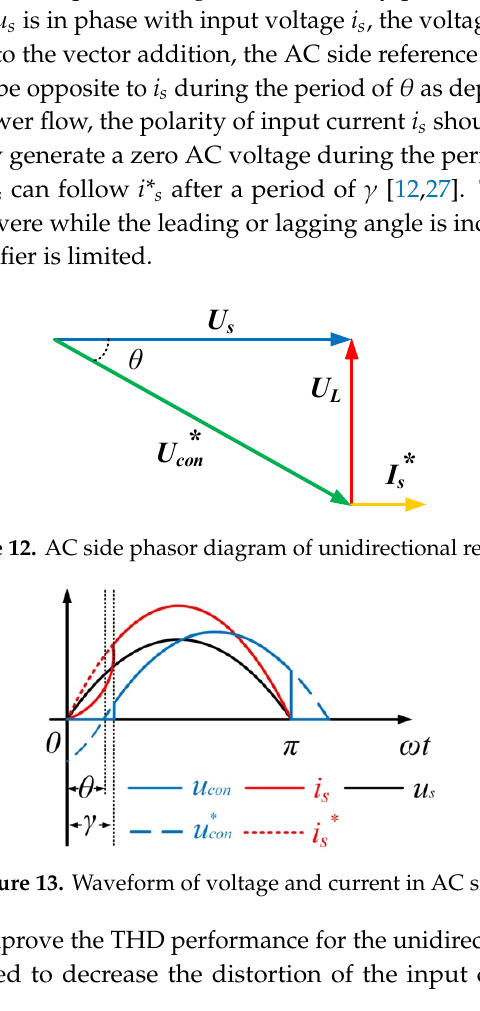
Figure 11. Input current and input voltage waveforms ( a ) cascaded three-phase H-bridge rectifier; ( b ) cascaded three-phase bridgeless rectifier.